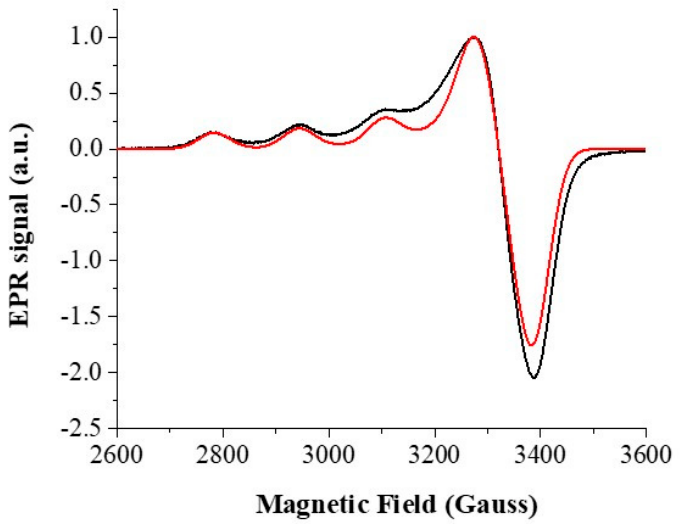
Figure 3. X-band EPR spectrum of complex Cu-1 in frozen DMSO solution (T = 120 K). Black line: experimental; red line: simulation. Experimental conditions: mw frequency, 9.612 GHz; mw power incident to the cavity, 200 µW; modulation frequency, 100 kHz; modulation amplitude, 0.13 mT.